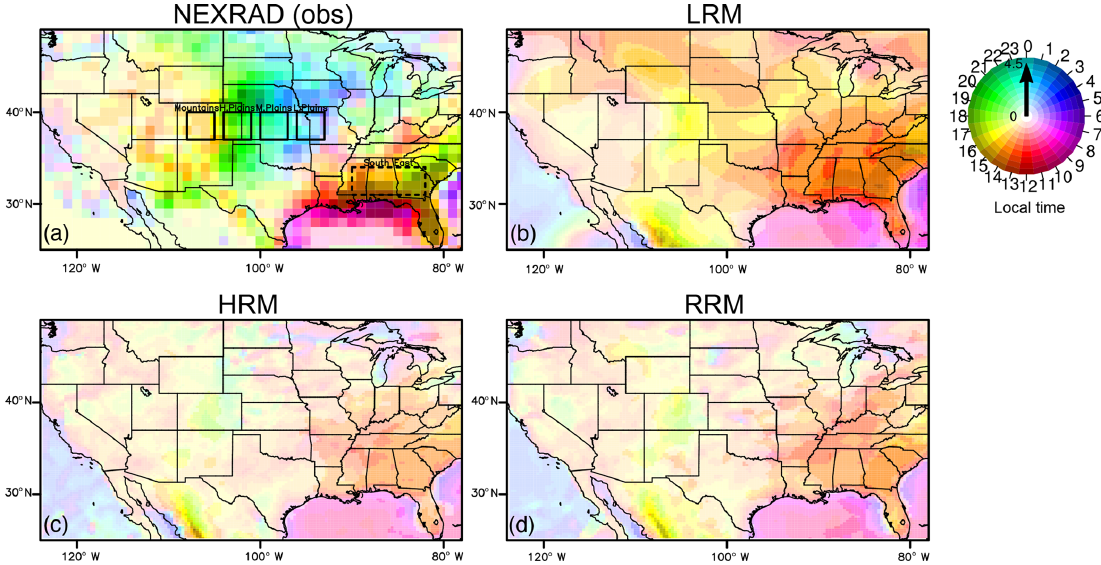
Figure 15. Mean diurnal phase (local time; unit: hours) and magnitude (unit: mmd − 1 ) of the maximum precipitation in JJA calculated from the first harmonic for (a) NEXRAD observations, (b) LRM, (c) HRM, and (d) RRM. The phase is indicated by colors, while the magnitude is indicated by the saturation of the color. In panel (a) , the solid boxes denote four central US regions from west to east: mountains (37–40 ◦ N, 105–108 ◦ W), high plains (37–40 ◦ N, 101–104 ◦ W), middle plains (37–40 ◦ N, 97–100 ◦ W), and low plains (37–40 ◦ N, 93–96 ◦ W). The dashed box marks the southeast (31–34 ◦ N, 82–90 ◦ W) regions.